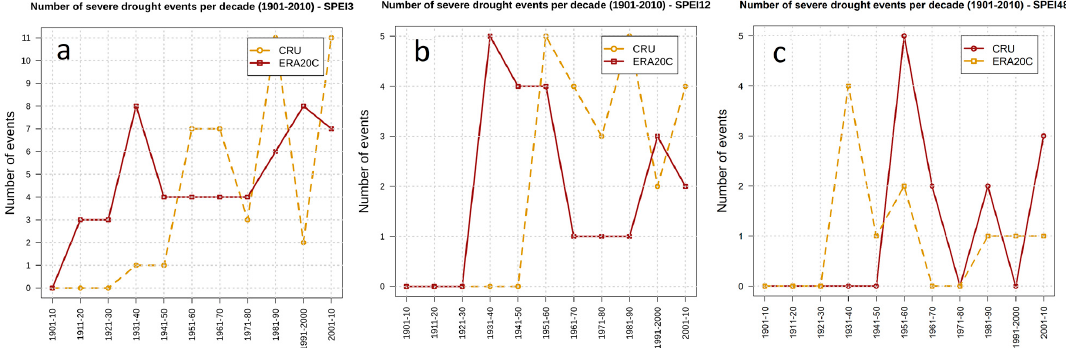
Figure 10. As in Figure 7, but for the CWSP